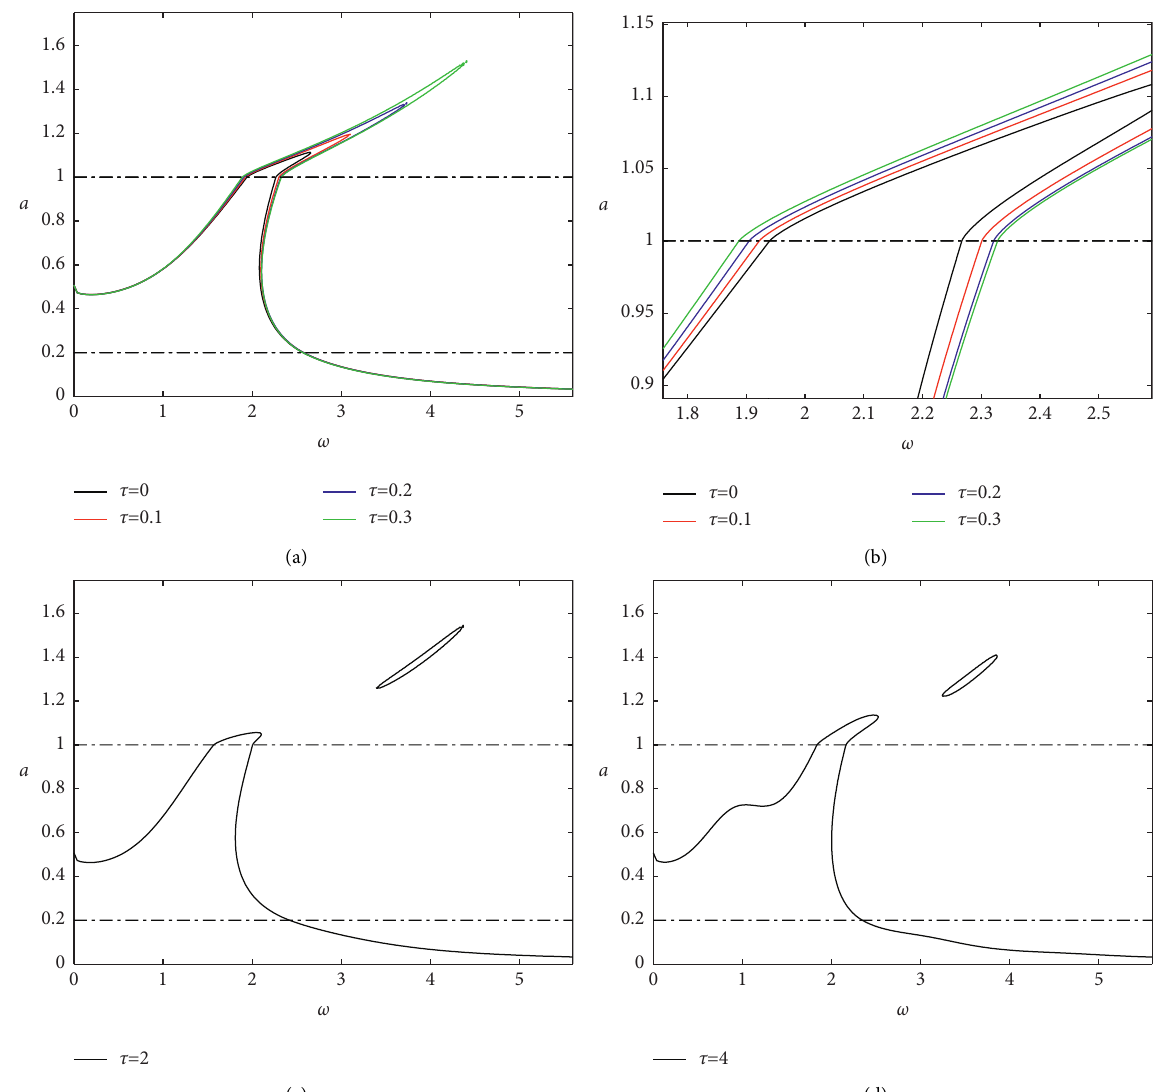
Figure 4: Amplitude frequency response curve with time lag and its partial enlargement. (a) The amplitude frequency response curve changes with time delay ( τ � 0 , τ � 0 . 1 , τ � 0 . 2 , and τ � 0 . 3 ) . (b) Partial enlarged drawing ( τ � 0, τ � 0.1, τ � 0.2, τ � 0.3). (c) The amplitude frequency response curve changes with time delay ( τ � 2 ) . (d) The amplitude frequency response curve changes with time delay ( τ � 4 )